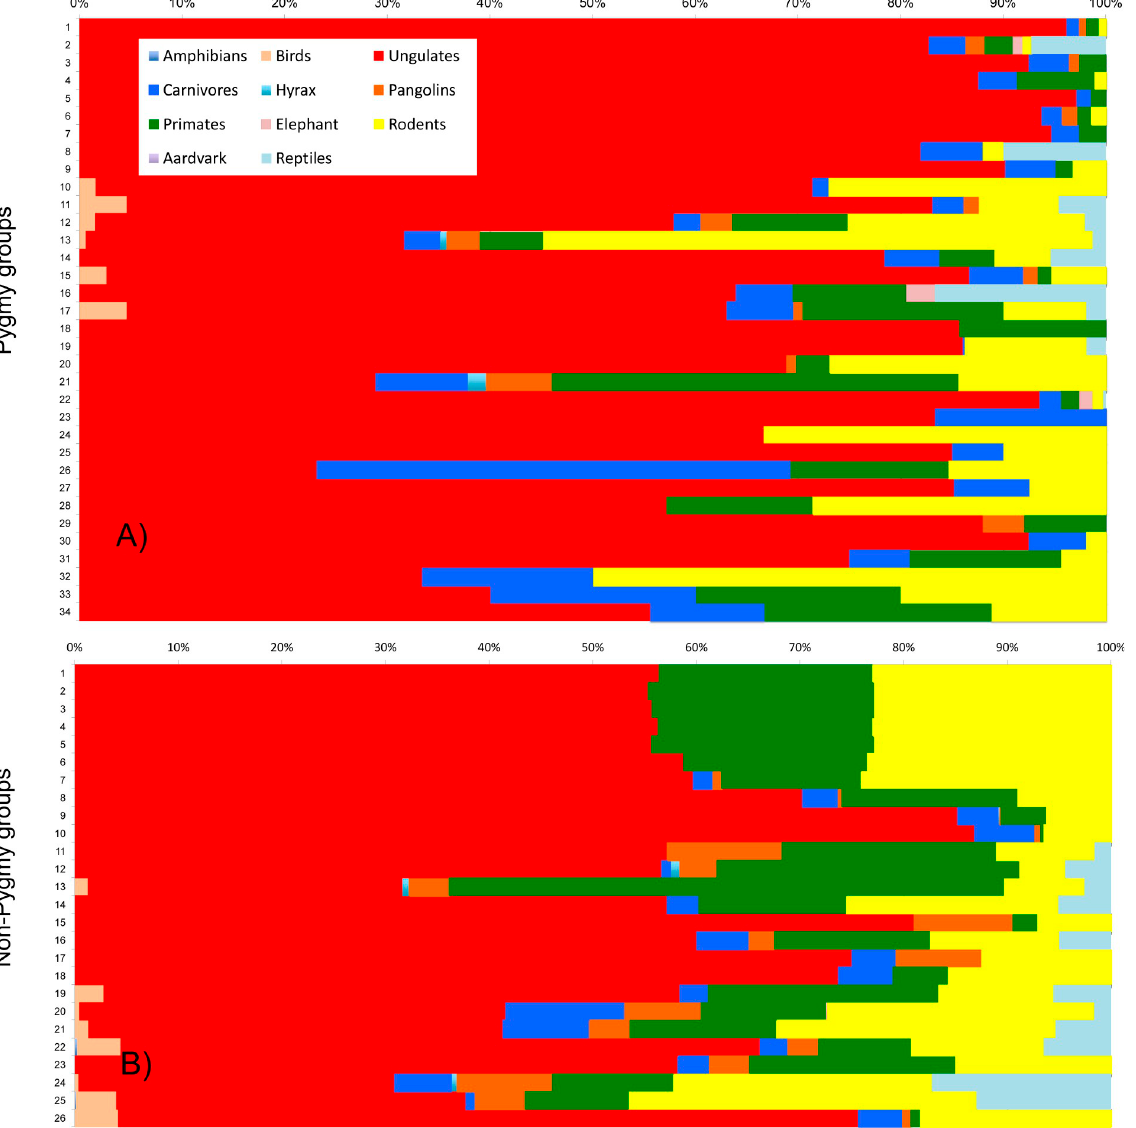
Harvest and Extraction Rates Per capita harvest rates calculated separately for all Pygmy and non-Pygmy sites (Table 1) showed that there were almost twice as many hunted animals per inhabitant in non-Pygmy sites but no significant difference in prey biomass per inhabitant was found between hunter